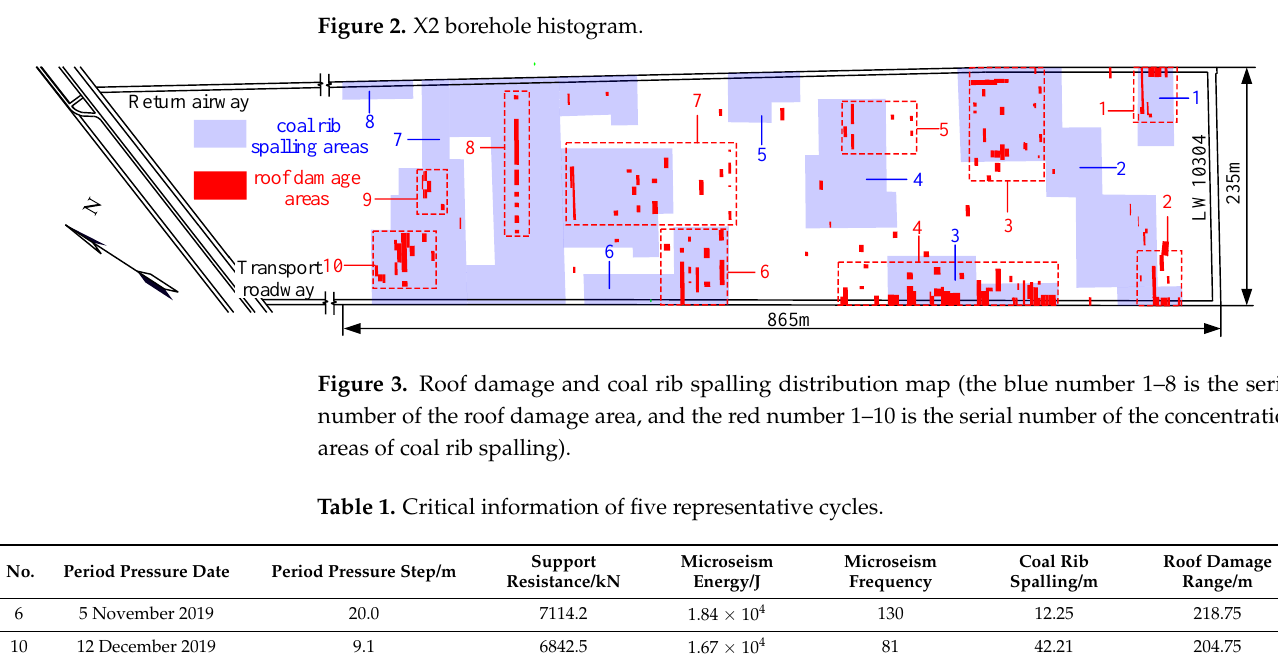
Figure 2. X2 borehole histogram.